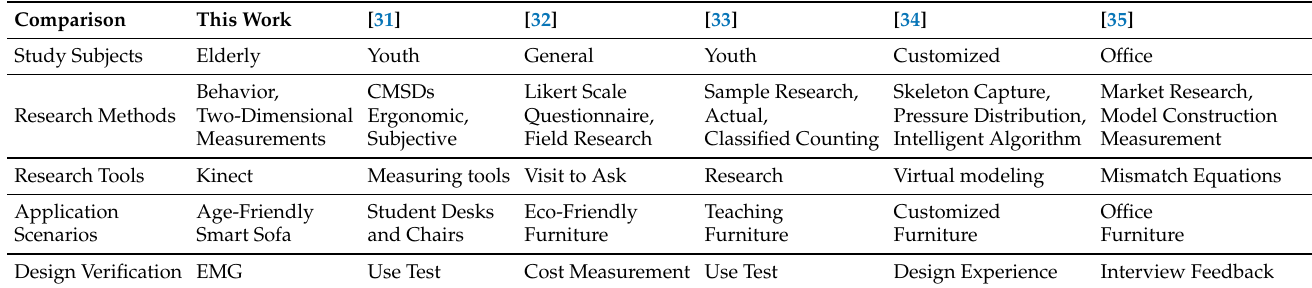
Table 5. Comparison of this work with the rest of the